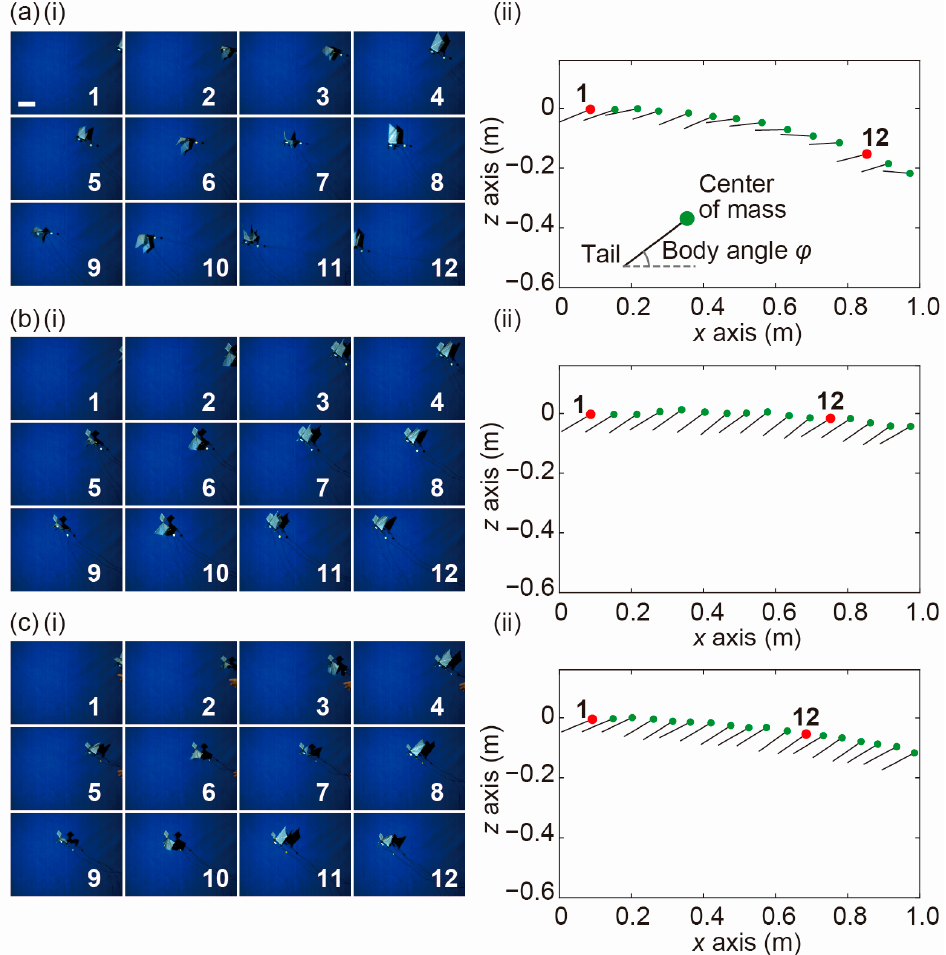
Figure 5. ( i ) High-speed camera images and ( ii ) trajectory of the ornithopter ( a ) without forewings; ( b ) with flapping forewings, and ( c ) with fixed forewings. The high-speed camera images are shown for intervals of 20 ms; The scale bar in ( a-i-1 ) is 100 mm. All images are provided with same scale. The trajectory is plotted with the coordinates of the center of mass and body axis every 20 ms. The trajectories with red dot are corresponding to the camera images of 1 and 12.